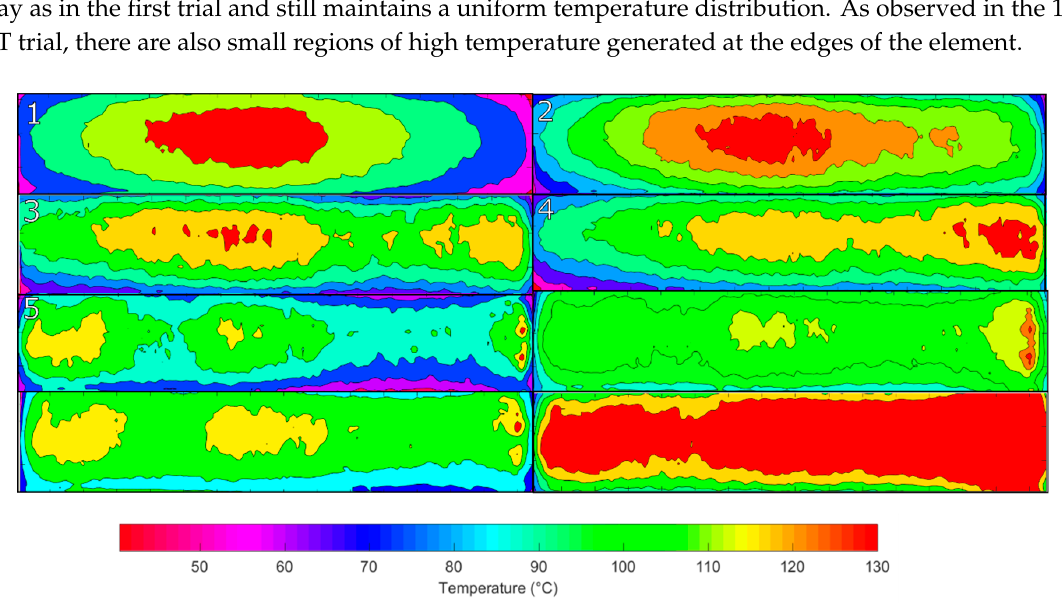
Figure 18. The second repetition of the Greyscale–Threshold hybrid (GT) method is shown in the contour plots of the surface temperature profile measurements shown after each cycle of ablation.